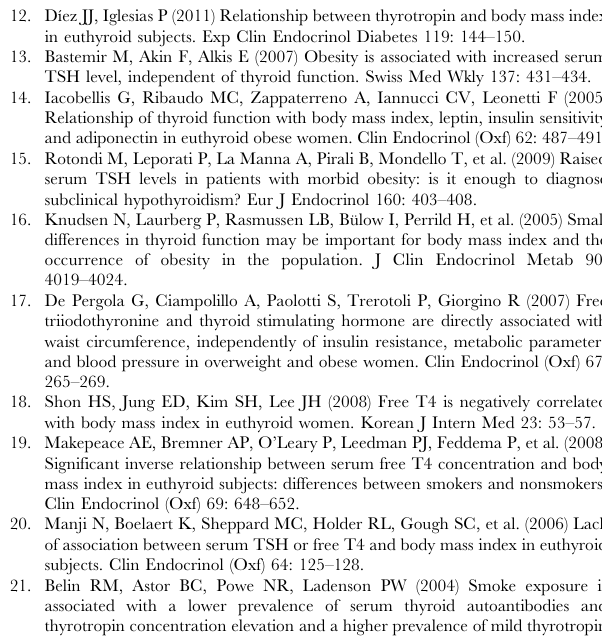
Figure S1 Association between BMI and mean TSH levels in euthyroid men (n =1,623) and euthyroid women (n =1,491), NHANES 2007–2008. Models used restricted